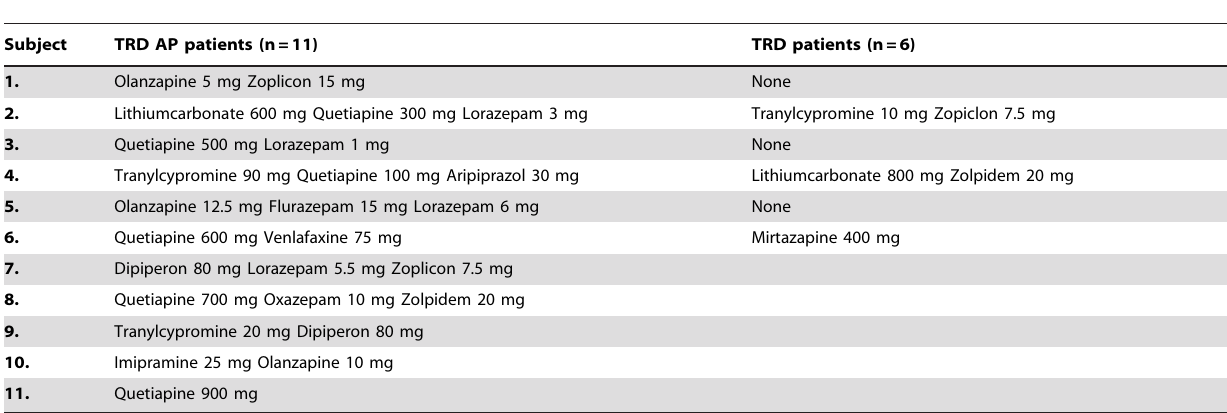
Table 2. Psychopharmacological drugs used in TRD and TRD AP